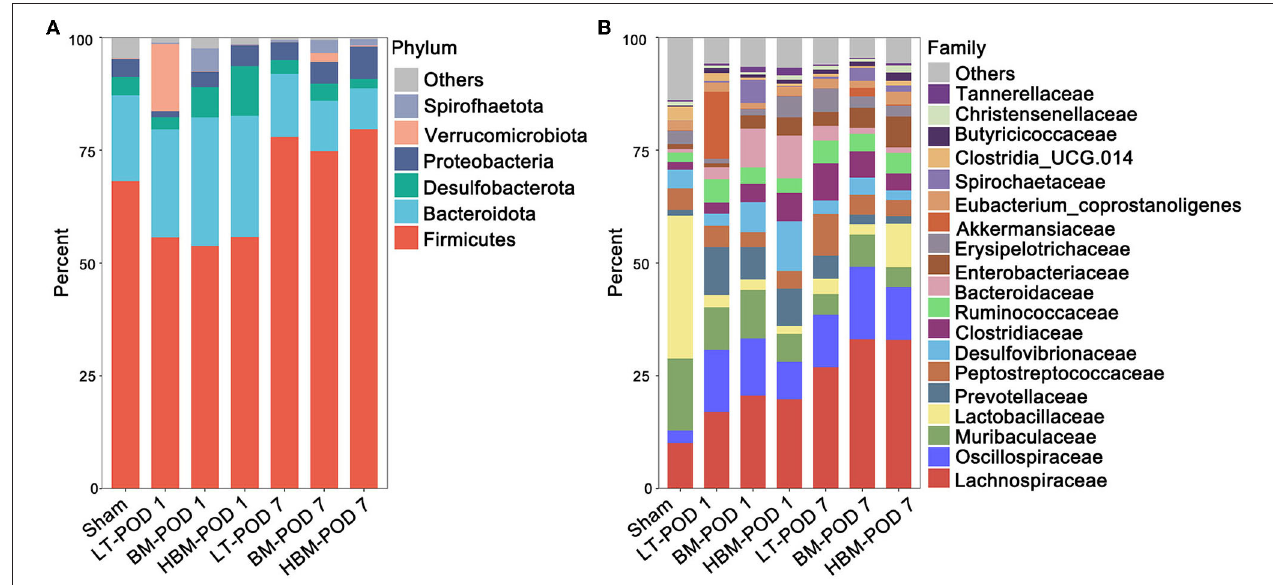
FIGURE 5 | Changes in intestinal microbiota in the recipients. (A) Species composition and abundance of each group at the phylum level. Firmicutes phylum levels increased significantly on POD 7, and Bacteroidota phylum levels decreased significantly on POD 7. (B) Species composition and abundance of each group at the family level. Under the function of MSCs, the abundance of the Lachnospiraceae family increased significantly on POD